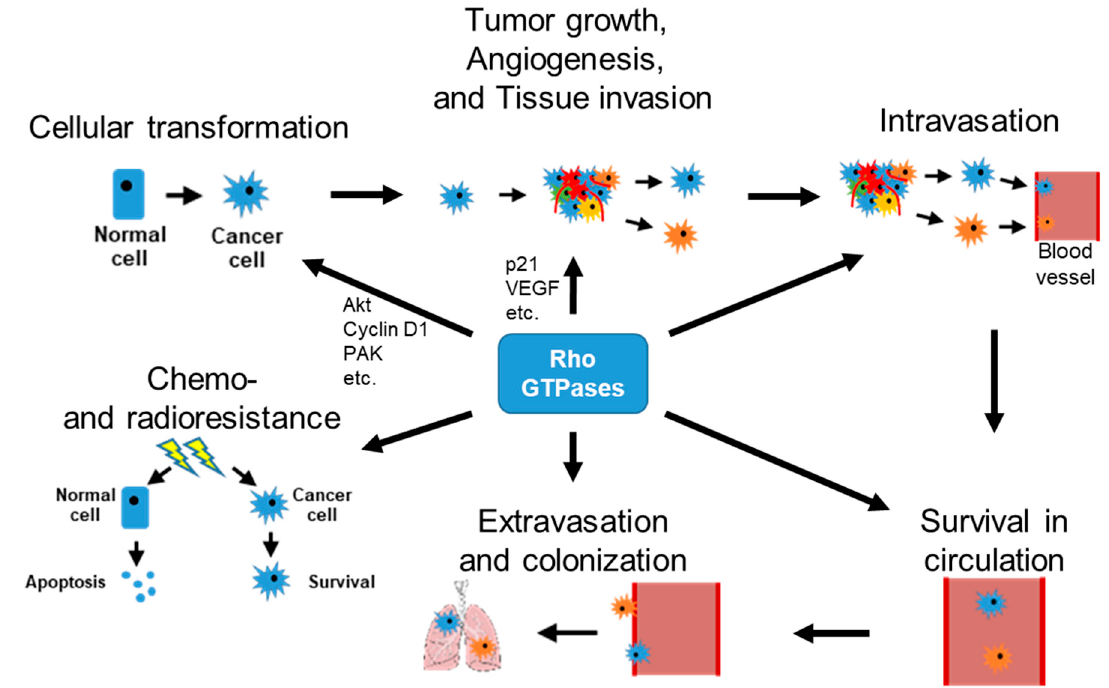
Figure 3. Effects of Rho GTPases on steps of cancer initiation and metastatic progression. Although some studies have shown conflicting data (specifically in the case of Rho), the literature generally agrees that increased activation of Rho GTPases results in breast cancer initiation, metastatic progression, chemoresistance and radioresistance.